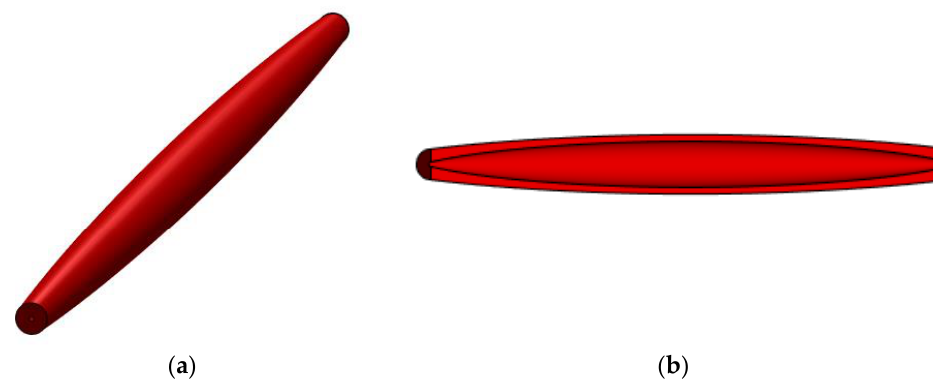
Figure 8. Geometrical model for s bar with sinusoidal variation in the second moment of inertia along the bar axis: ( a ) isometric view and ( b ) longitudinal section.